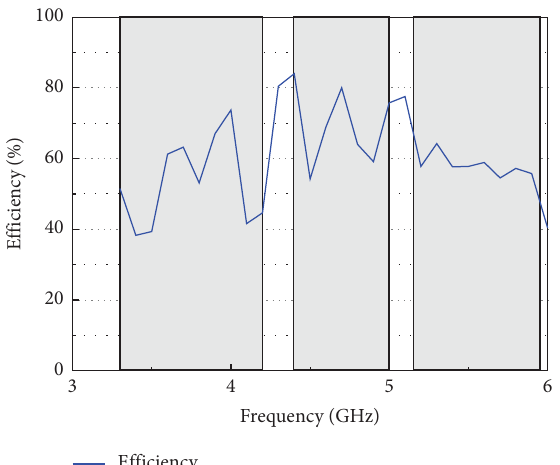
Figure 10: Measured antenna total efciency.